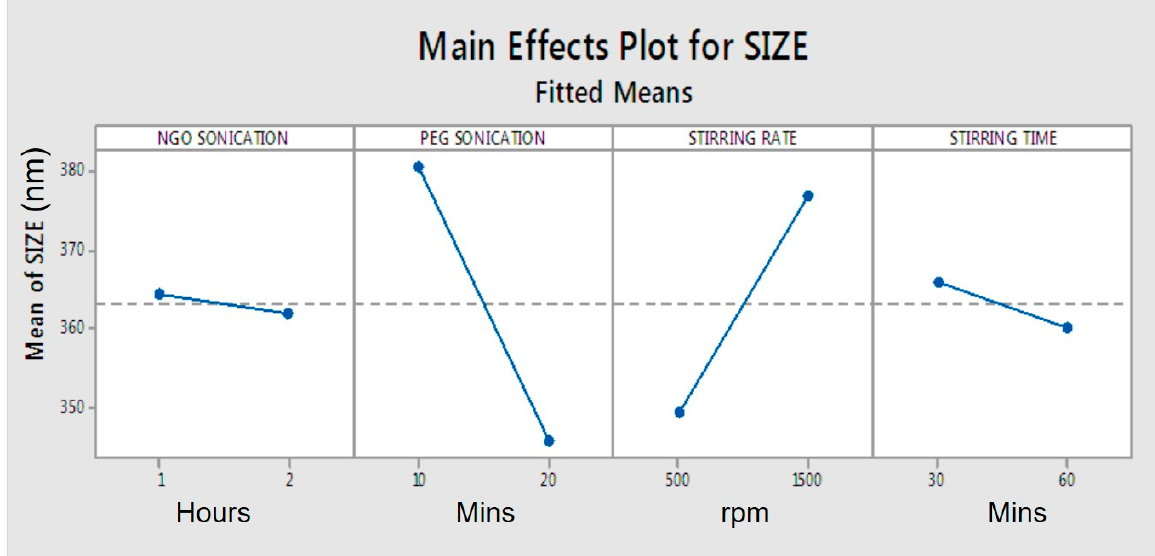
Figure 1. Main effect plots for the impact of process parameters on average particle size.